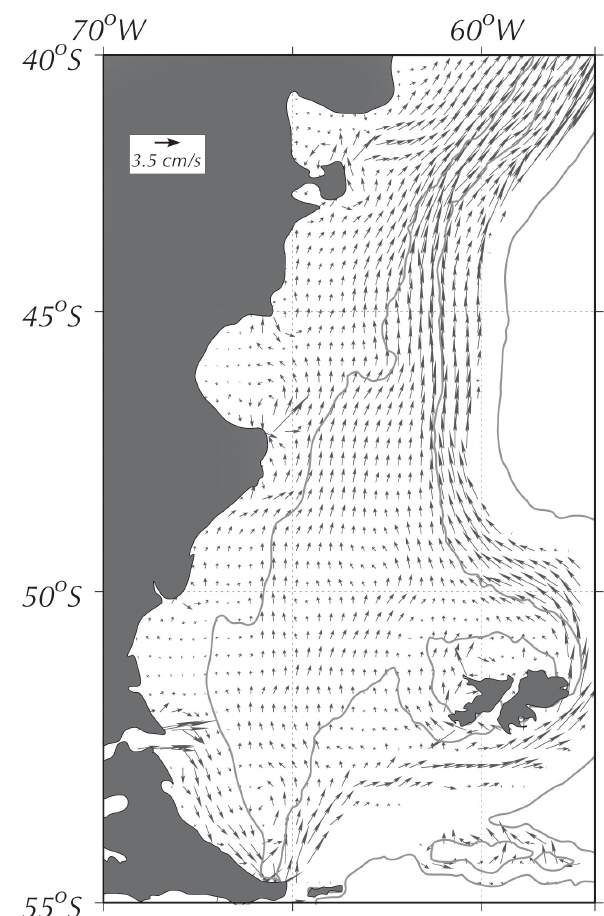
Fig. 6. Depth averaged circulation over the Patagonia shelf (depths smaller than 500m), in